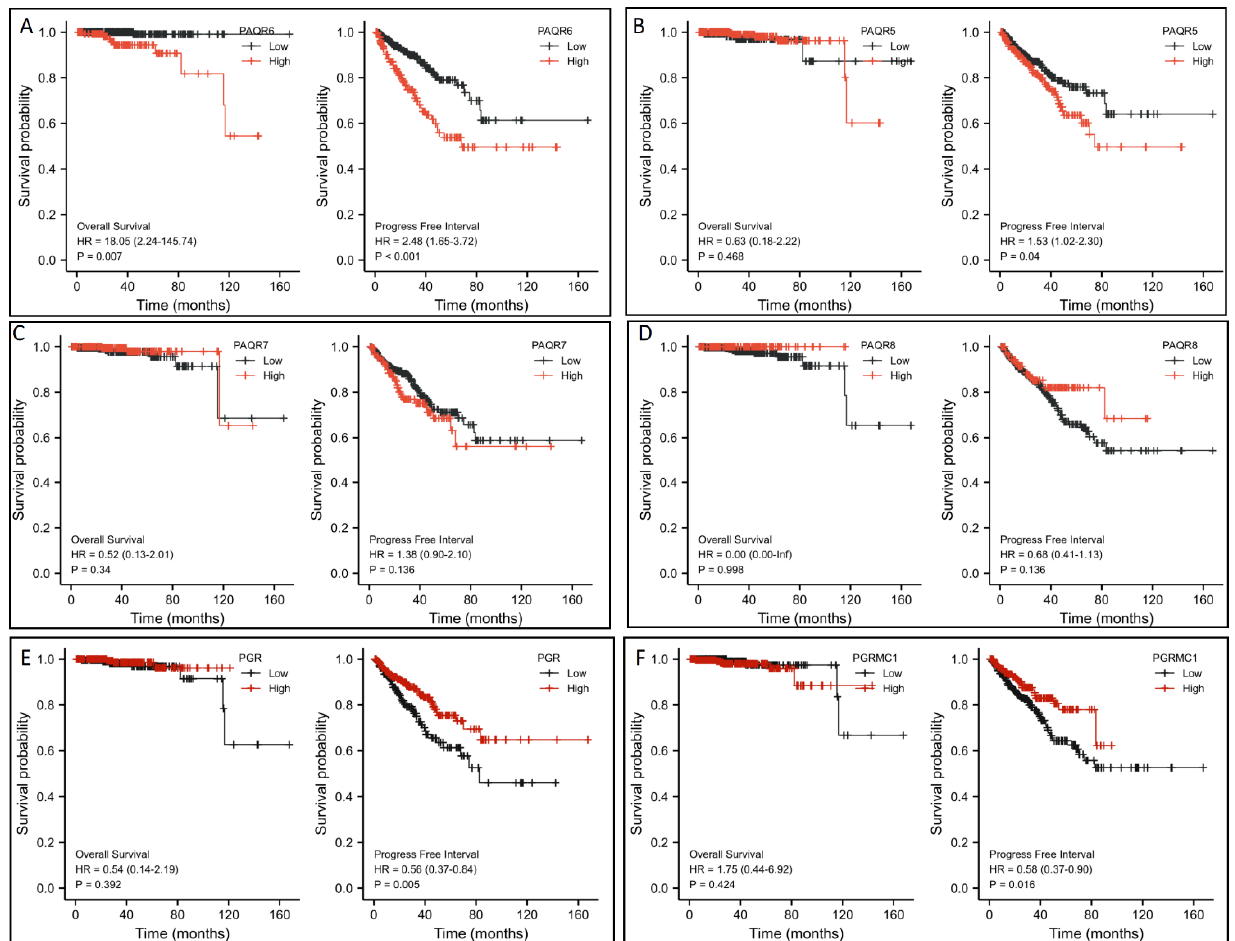
Figure 4. ( A – F ) Association of PAQR gene expression with patient survival outcomes in prostate cancers. Patient survival outcomes were analyzed using the TCGA dataset with the Kaplan-Meier plot using the R survival package (version 3.2-10). Data figures were generated using the R survminer package (version 0.4.9). The hazard ratio (HR) was calculated using the Cox regression analysis and tested using the log-rank test.